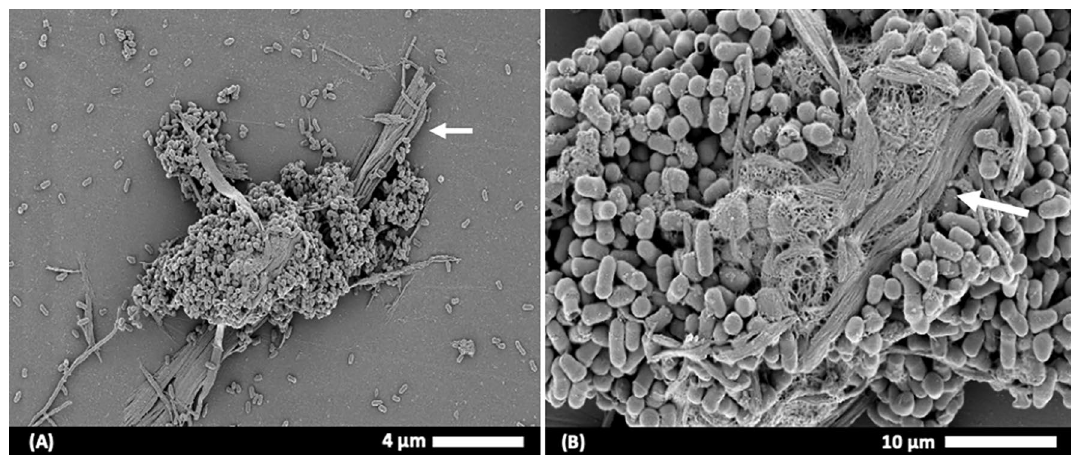
Figure 5. Field emission-scanning electron microscopy (FE-SEM) images of adhesion of strain USB13 T to degraded filter paper fibers. Arrows indicate filter paper fibers. ( A ) low magnification (5000 × ) and ( B ), high magnification (20,000 × ) images of strain USB13 T surrounding filter paper